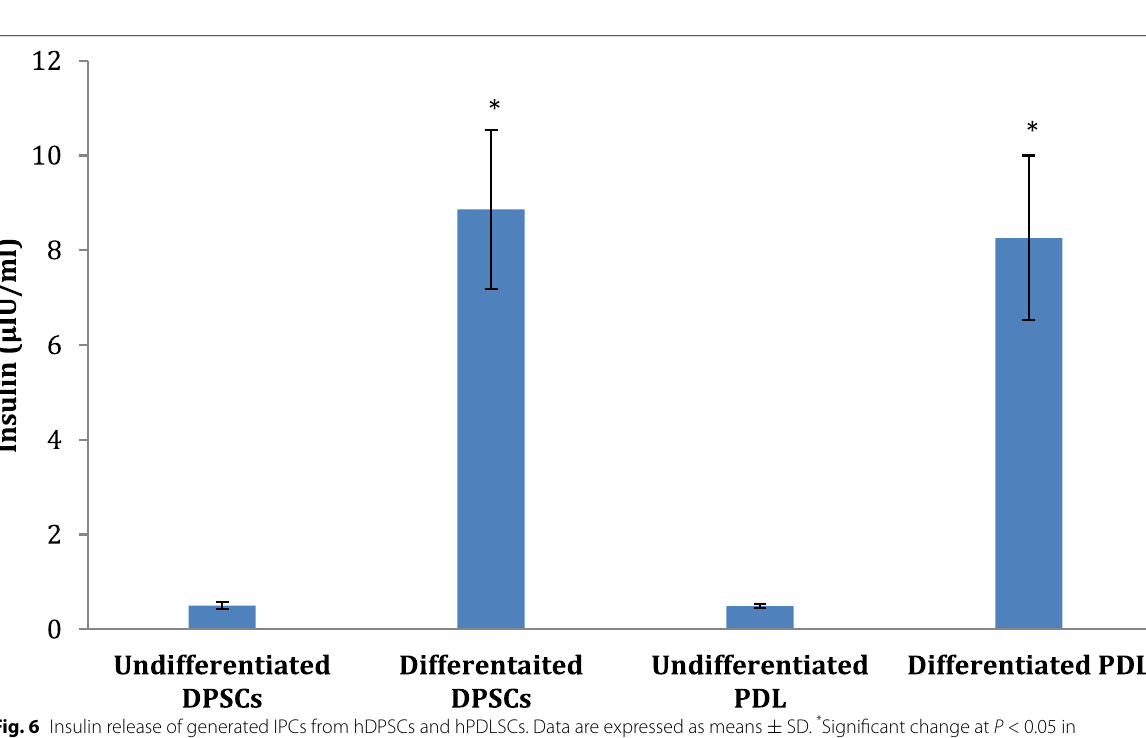
Fig. 6 Insulin release of generated IPCs from hDPSCs and hPDLSCs. Data are expressed as means comparison with the corresponding undifferentiated